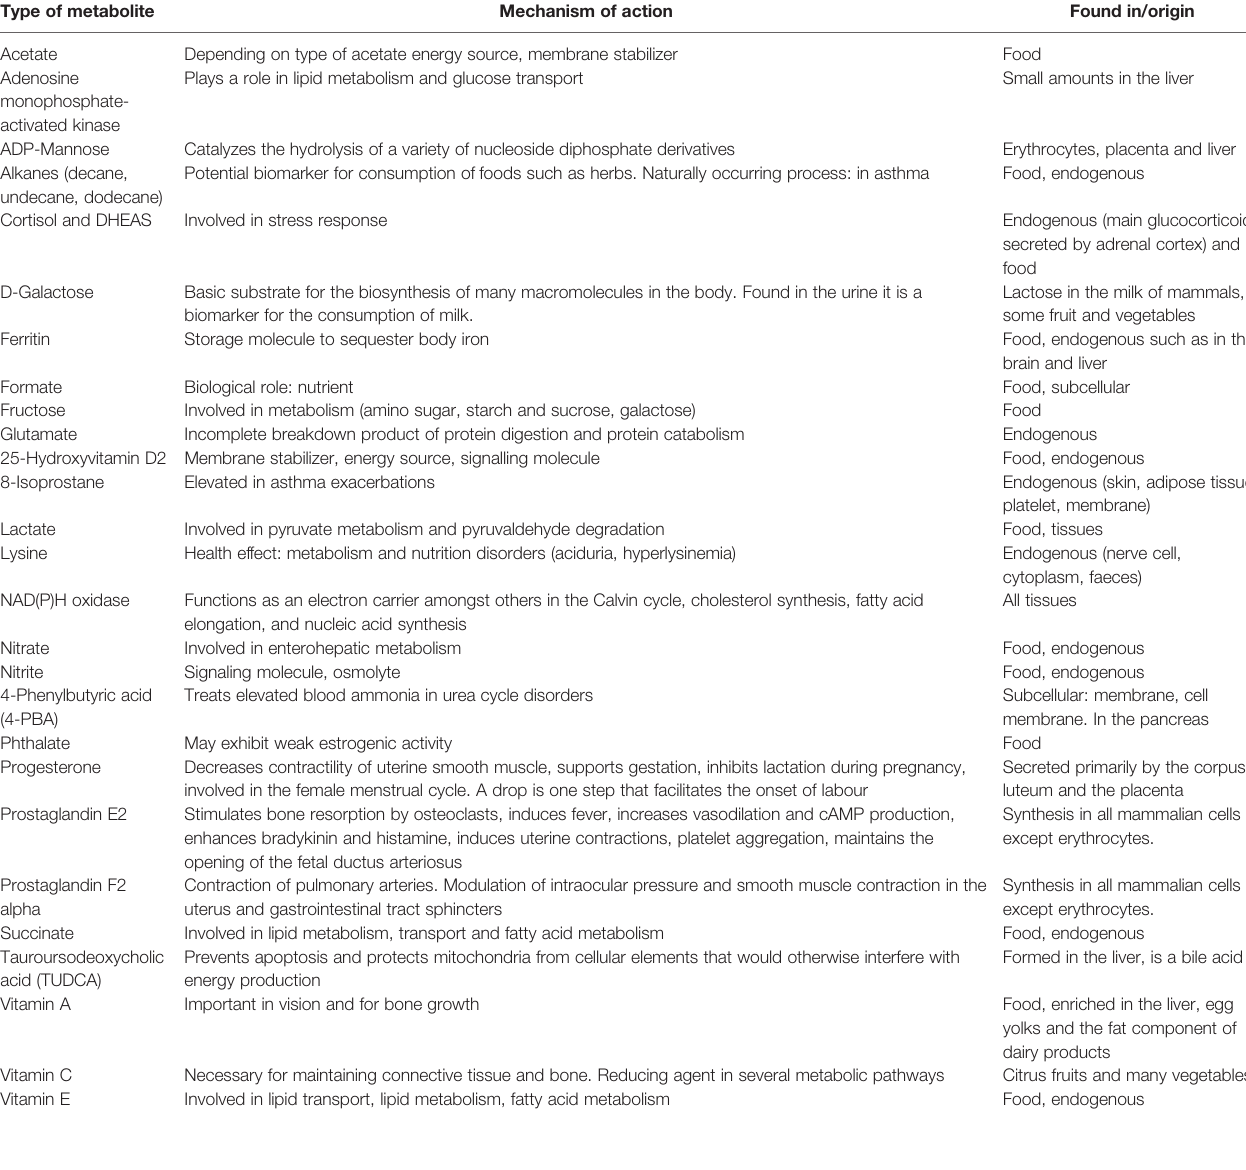
TABLE 1 | Included metabolites based on the Human Metabolome Database